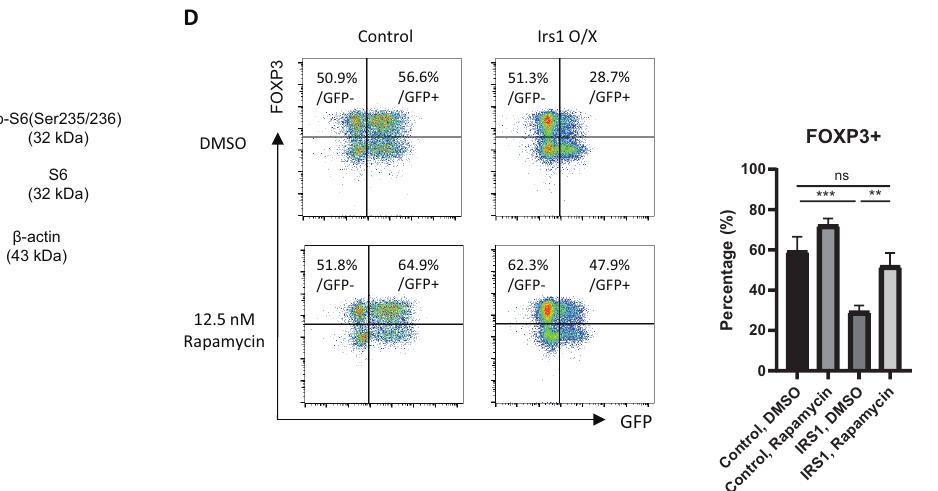
Figure 6. IRS1 signaling activates the mTORC1, but not the JAK/STAT and ERK pathways. ( A ) Schematic of the signaling activation experiments. ( B , C ) Signaling molecules were stained with appropriate antibodies, and cells were analyzed via flow cytometry ( B ) and via Western blot analysis ( C ). ( D ) Naïve CD4 T cells were cultured for 1 day under Th0 conditions and then trans- duced with the MIEG3-IRS1 vector. Transduced cells were cultured for 2 days under Treg-inducing conditions in the presence of DMSO (control) or rapamycin. The cells were then analyzed via flow cytometry. All data are representative of three independent experiments. The bar graph next to the flow cytometry plot shows data pooled from three independent experiments. The error bars represent the SD, and ( B ) p -values were calculated using a t -test. ( D ) p -values were calculated using one-way ANOVA/Tukey test. * p < 0.05, ** p < 0.01, *** p < 0.001. ns: not significant.